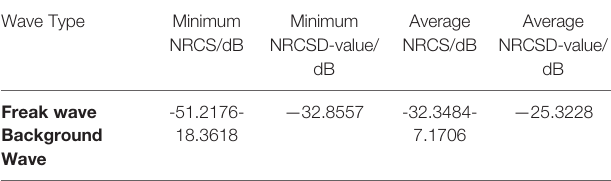
TABLE 2 | Comparison of NRCS values of two different types of